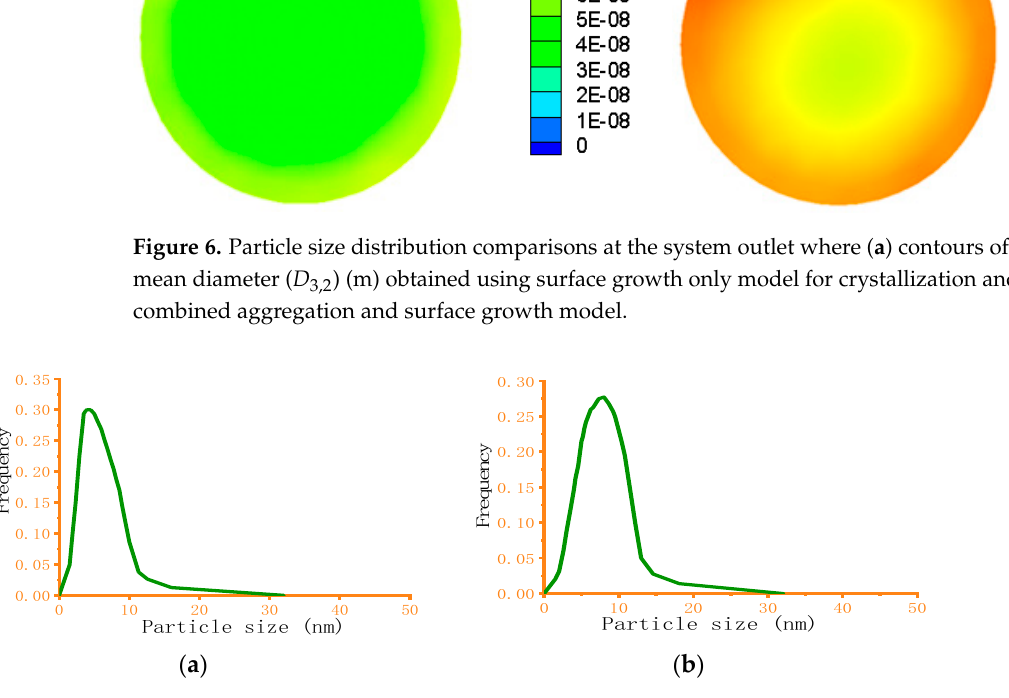
Figure 6. Particle size distribution comparisons at the system outlet where ( a ) contours of the Sau- ter mean diameter ( D 3,2 ) (m) obtained using surface growth only model for crystallization and ( b ) using combined aggregation and surface growth model.